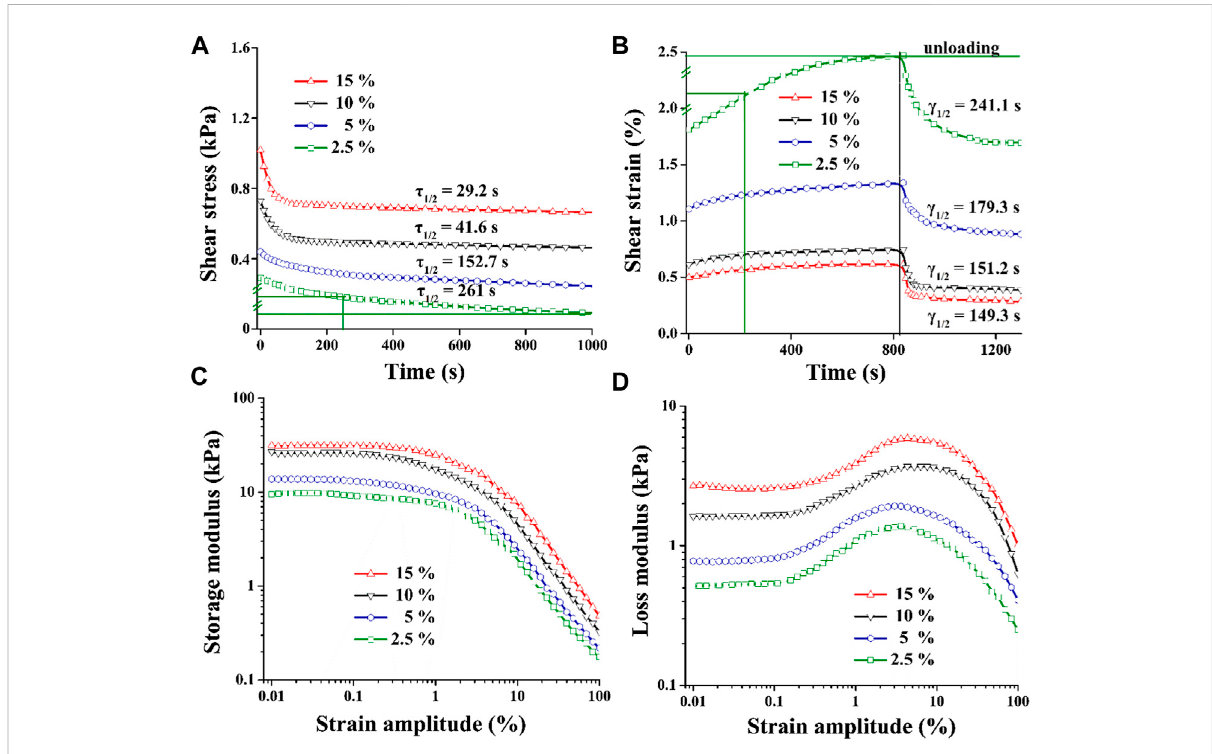
FIGURE 4 Viscoelastic properties of CNC/COL hydrogels with varying CNC concentrations. (A) stress relaxation, (B) creep, (C) storage modulus, and (D) loss